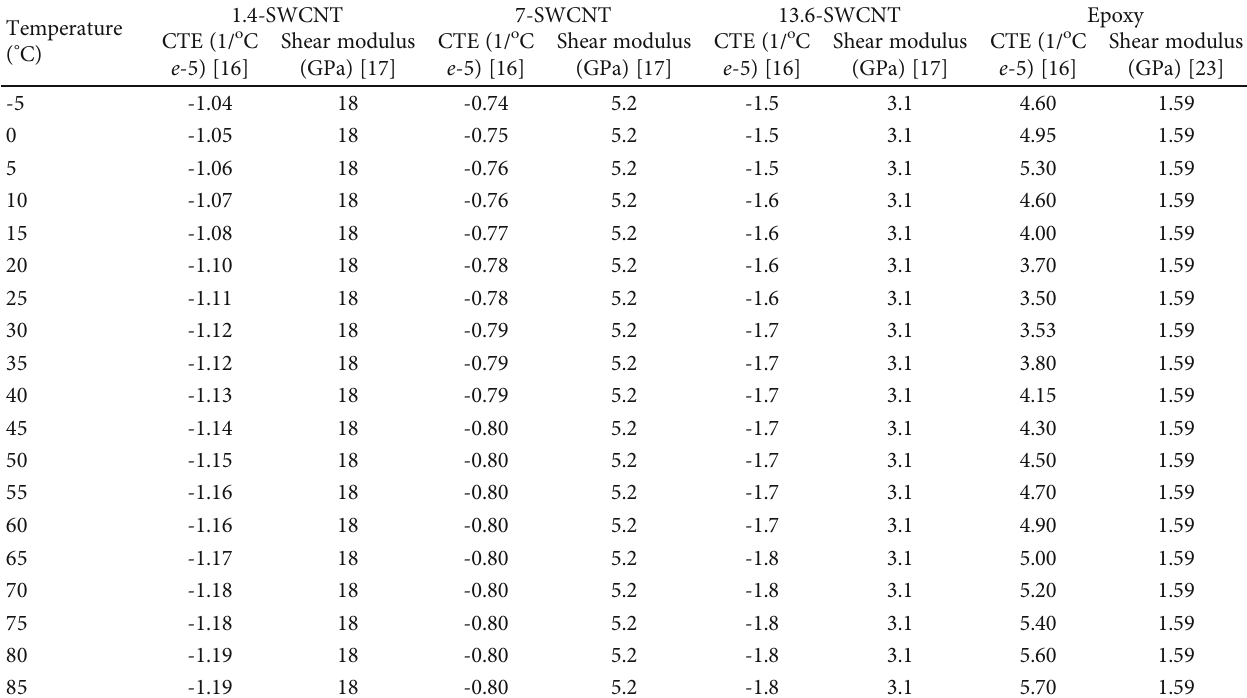
Table 4: CTEs and shear modulus of 1.4-SWCNT, 7-SWCNT, 13.6 SWCNT, and epoxy at a temperature range of -5 to 85 ° C. Temperature